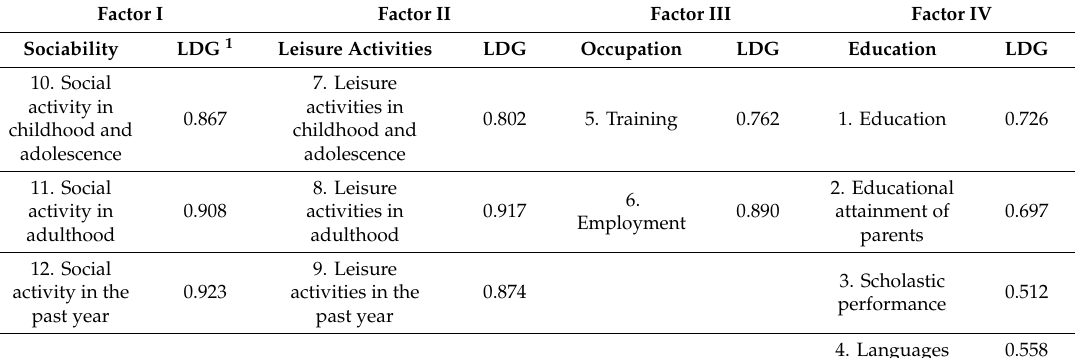
Table 3. Principal Components Factor Solution for Cognitive Reserve Assessment Scale in Health